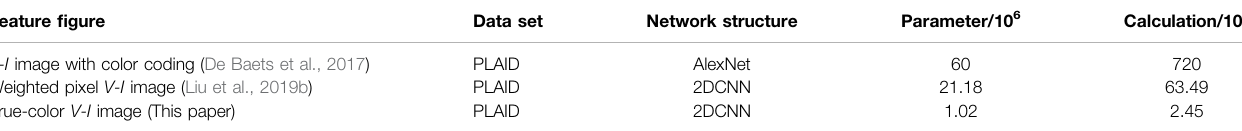
TABLE 2 | Comparison of network scales.